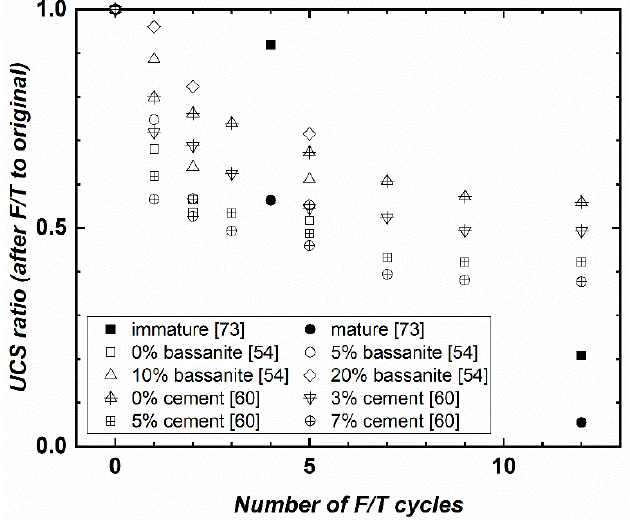
Figure 5. UCS ratio versus F/T cycles (adapted from [8,52,58]).